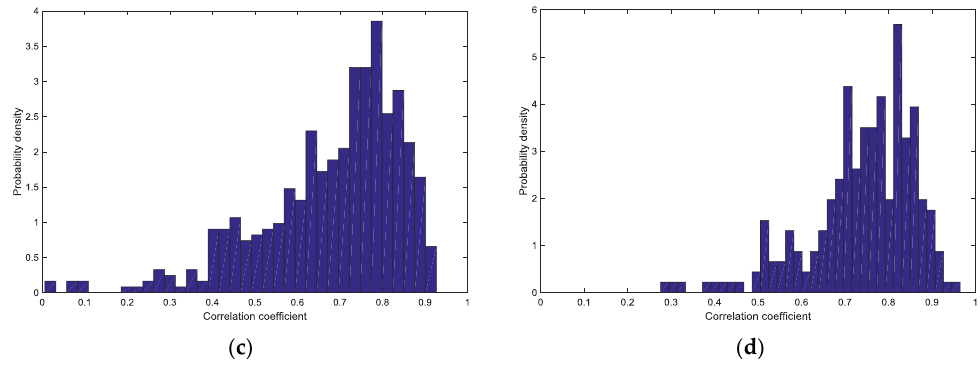
Figure 11. Probability density distribution of correlation coefficients of wind speed between wind farm QiaodongII and wind turbine A015 in different time scales: ( a ) 0.5 h; ( b ) 1 h; ( c ) 6 h; ( d ) 12 h. As the time interval gets longer, the wind speed series in time of the wind farm and its wind turbines tend to get positively correlated, which indicates that variation and change of wind speed series tends to coincide in a long period (over 1 h). And as the time interval gets shorter, the Pearson coefficient values distribute between a negative correlation (−1) and a positive correlation (1), indicating a volatility and randomness in wind speed series of wind turbines located in the wind farm in a short period (under 1 h).